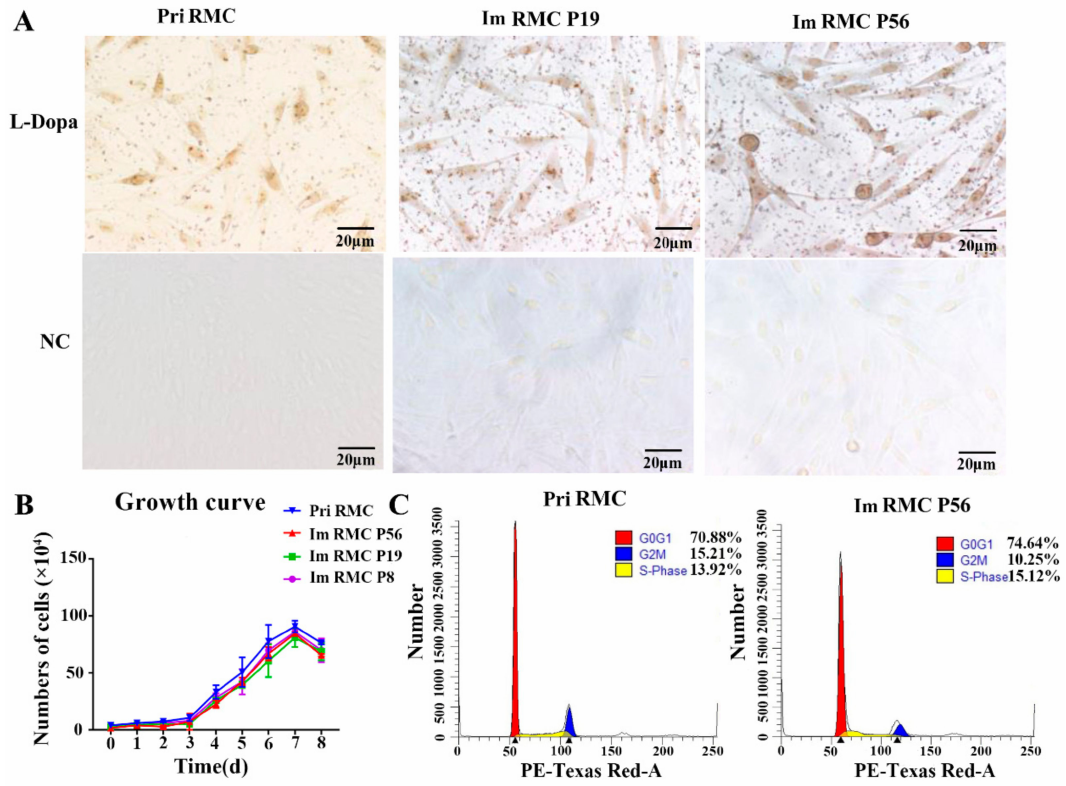
Figure 2. Morphology and proliferation of primary and immortalized melanocytes. ( A ) Identification of Dopa staining (400 × ). ( B ) Determination of growth curves. Im RMC P55 / P19 / P8 indicates the Im RMCs at passage 56 / 19 / 8. ( C ) Flow cytometry analysis. Pri RMC: primary